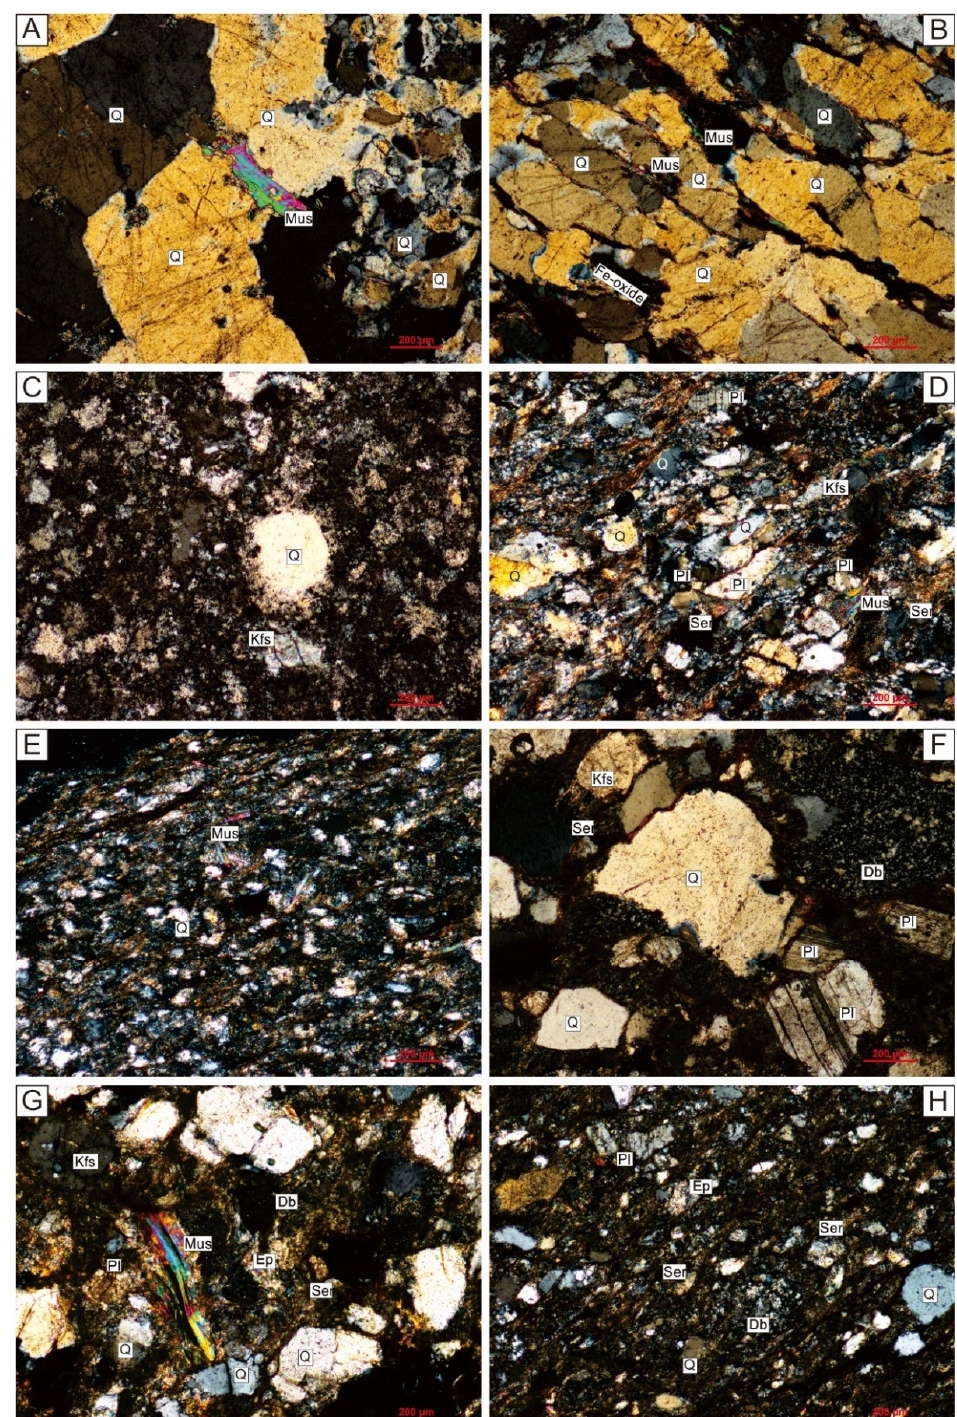
Figure 5. Microphotographs (crossed polarizers) showing textures and constitutions of the dated rocks from the Ondorkhan area in NE Mongolia. Panels ( A – H ) are for samples MOE-152, -216, -147, -41, -42, -44, -51, and -104, respectively. Please refer to main text and Table 1 for their petrographic details. Abbreviation: Db—debris; Ep—epidote; Kfs—potassic feldspar; Mus—muscovite; Pl—plagioclase; Q—quartz; Ser—sericite.